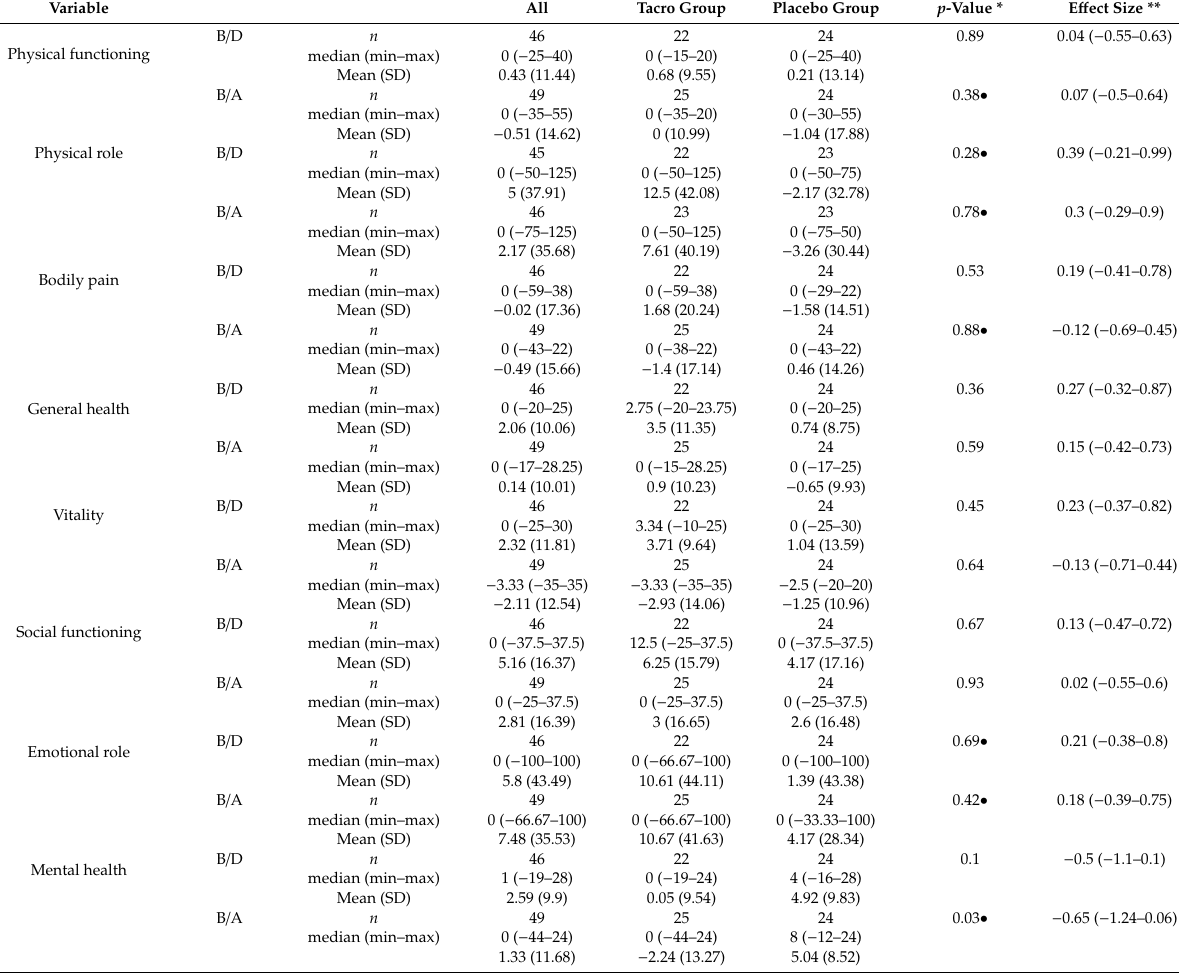
Table 3. Evolution of SF36 scores before and during treatment (B / D) and before and after treatment (B / A).